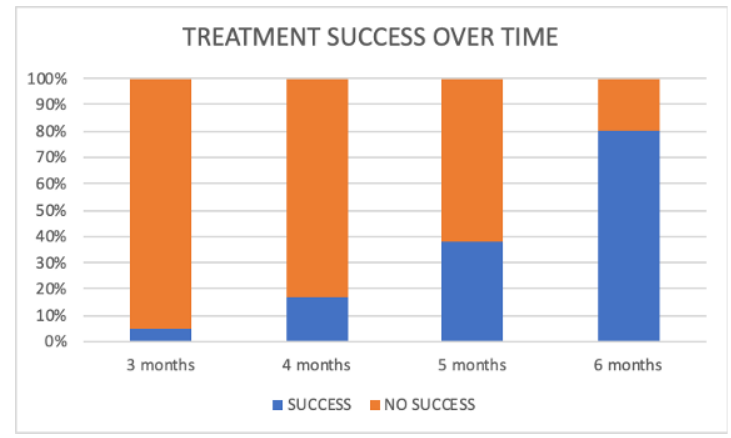
Figure 4. Increase in the percentage of subjects with treatment success vs. no success recorded over time in the whole sample ( n = 40).